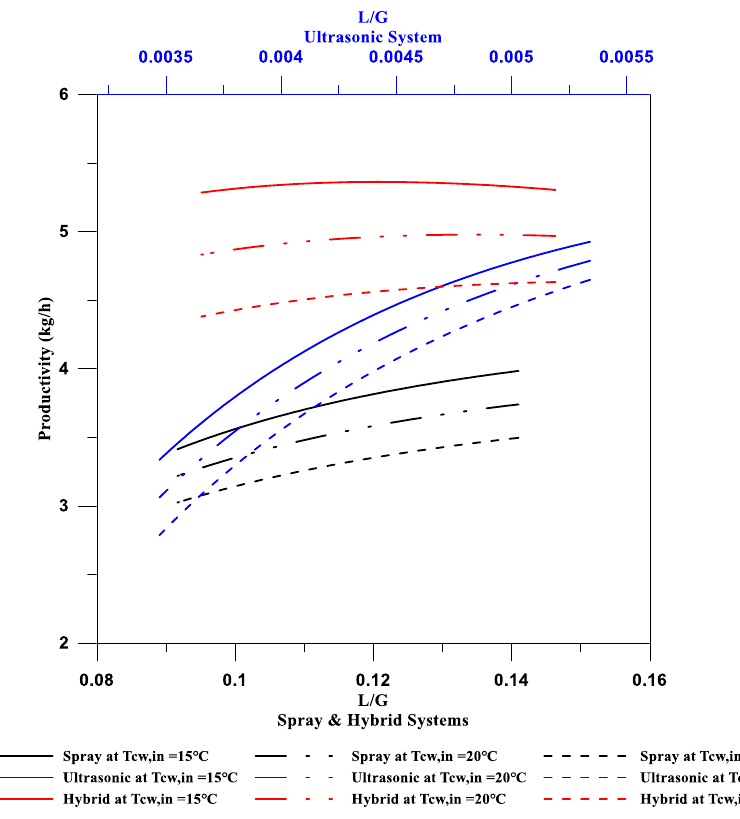
ff erent T cw, in